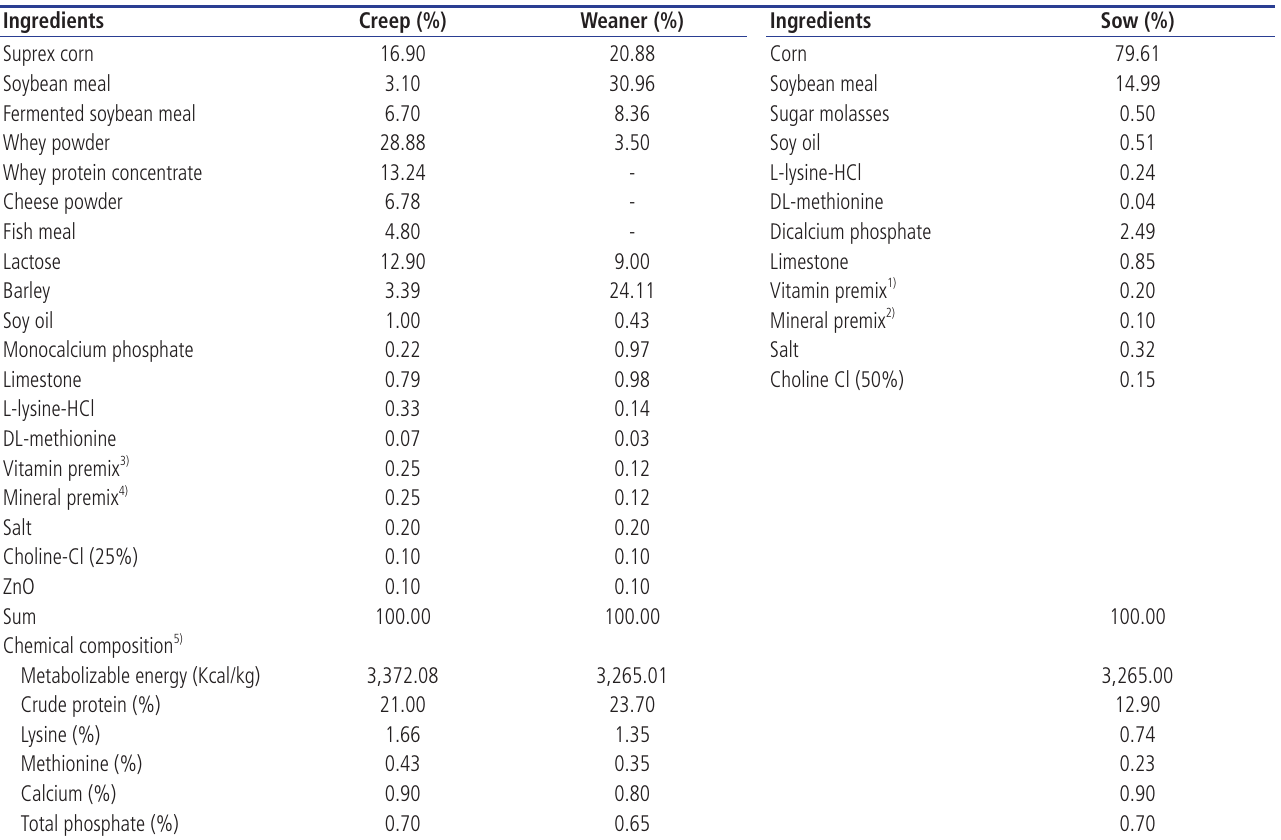
Table 1. Formula and chemical composition of creep diets in the experiment Ingredients